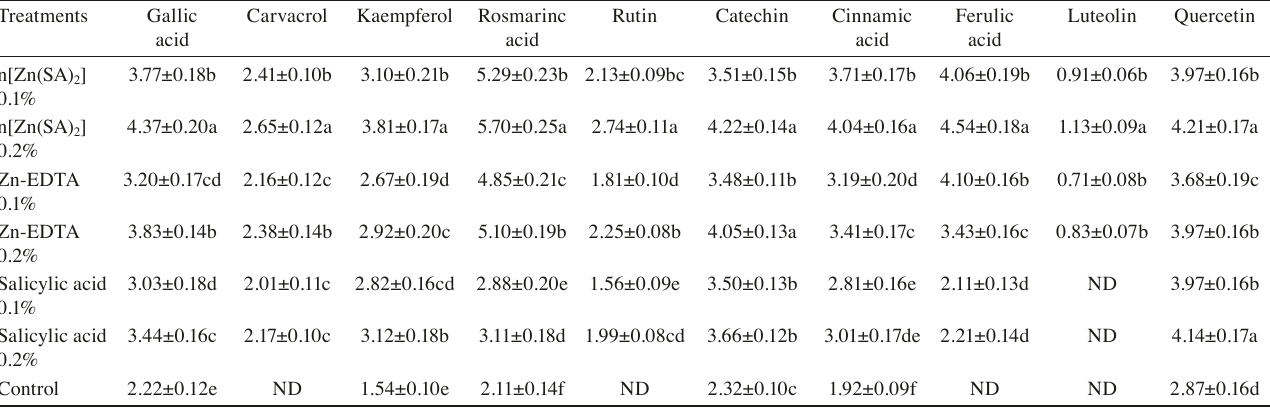
ND: Not detected *Calculated mean amount of the flavonoids and polyphenols (mg g -1 DM) based on the weight of the ground dry plant in eight replicates ± standard devia -